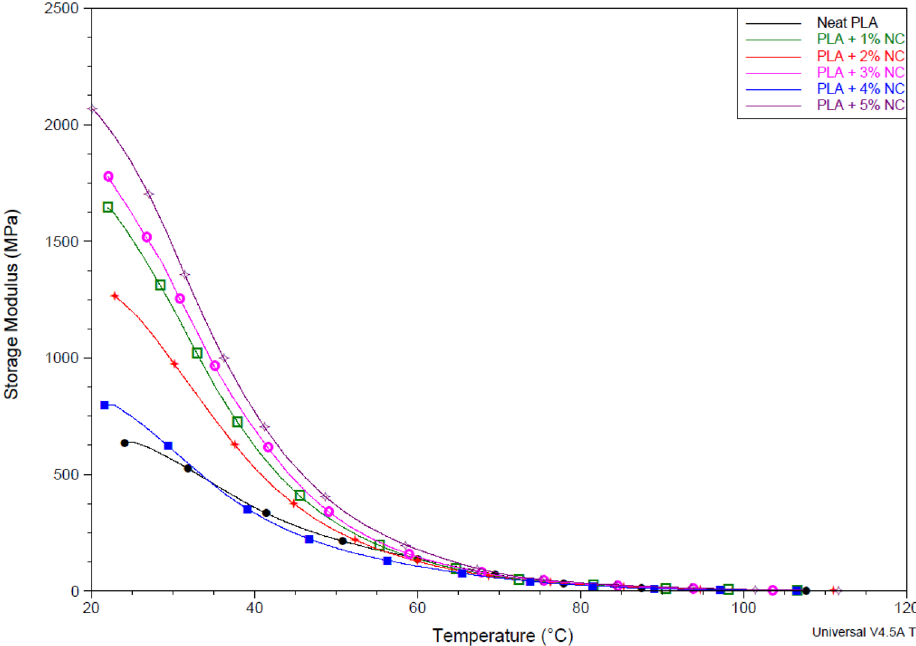
Figure 5. Storage modulus unfilled and nano-CaCO 3 reinforced polylactic acid bioplastic films.